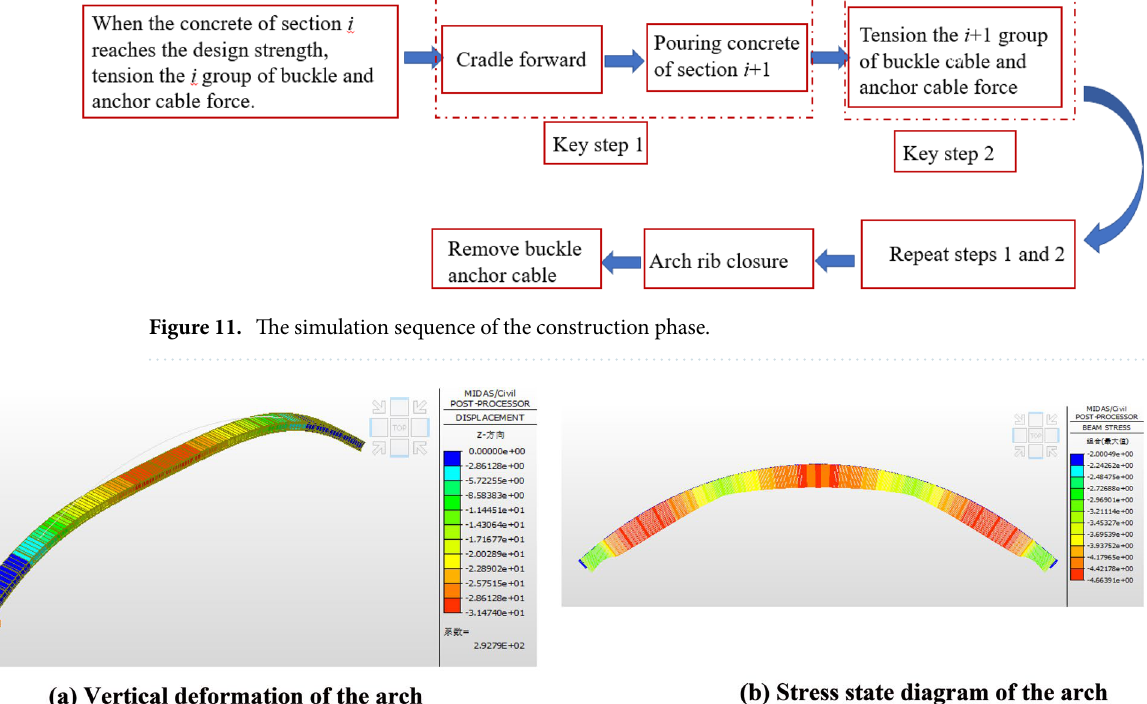
Figure 12. The stress and deformation of the arch after cable removal. ( a ) Vertical deformation of the arch. ( b ) Stress state diagram of the